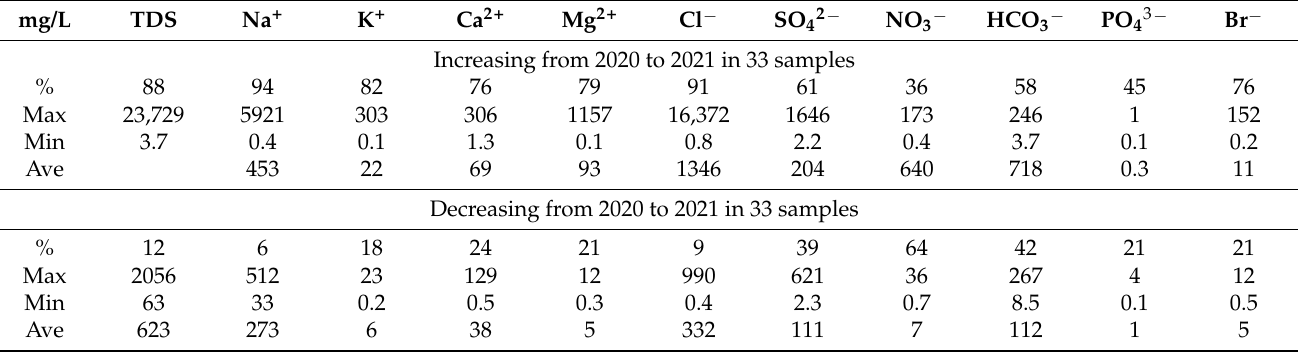
Table 3. Summary of chemical composition variation of 33 water samples.